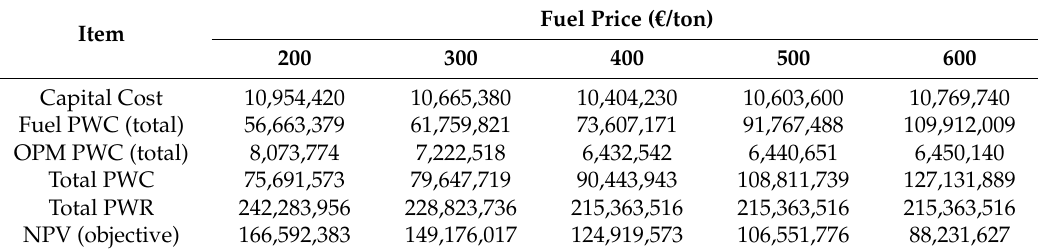
Table 38. Effect of fuel price on the optimal NPV for nominal freight rate (values in € ).